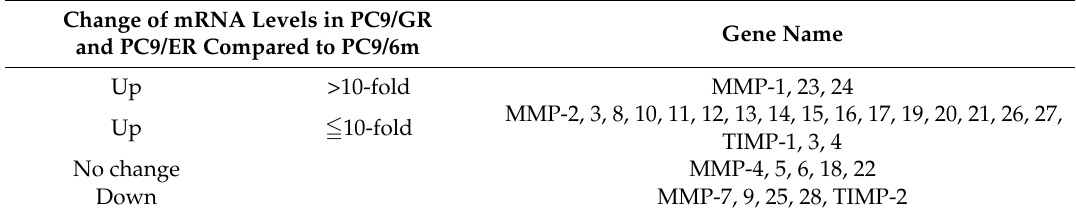
Table 1. Results of microarray of mRNA expression of MMPs and related genes.